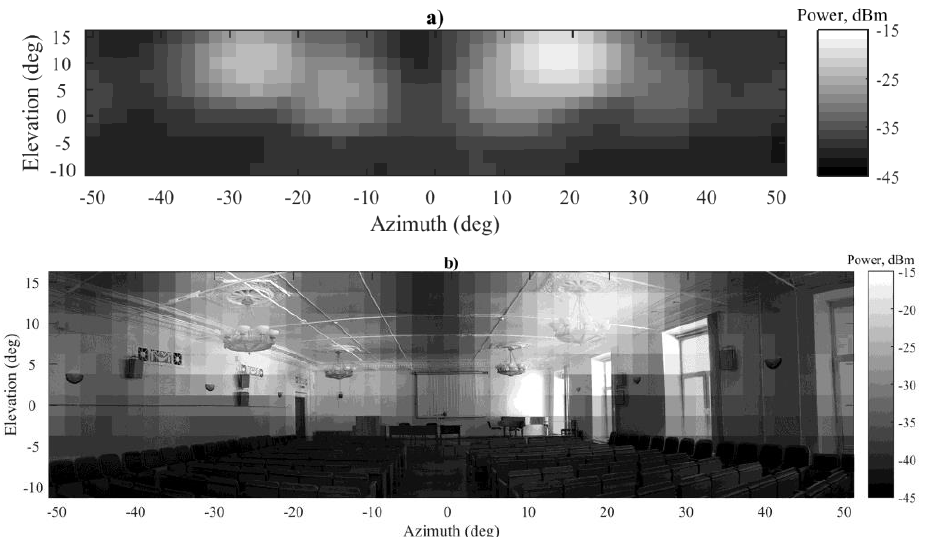
Fig. 4. Image of the hall lit by radiolight lamps (a); overlay of radiolight image with photo image